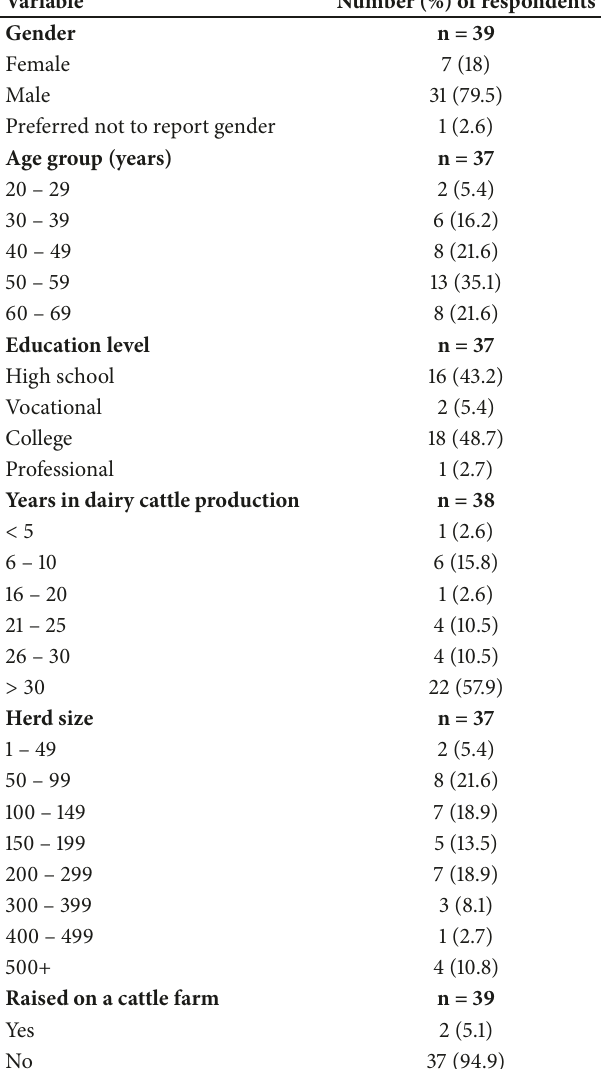
Table 1: Demographics of Tennessee dairy producers surveyed concerning antimicrobial use practices,